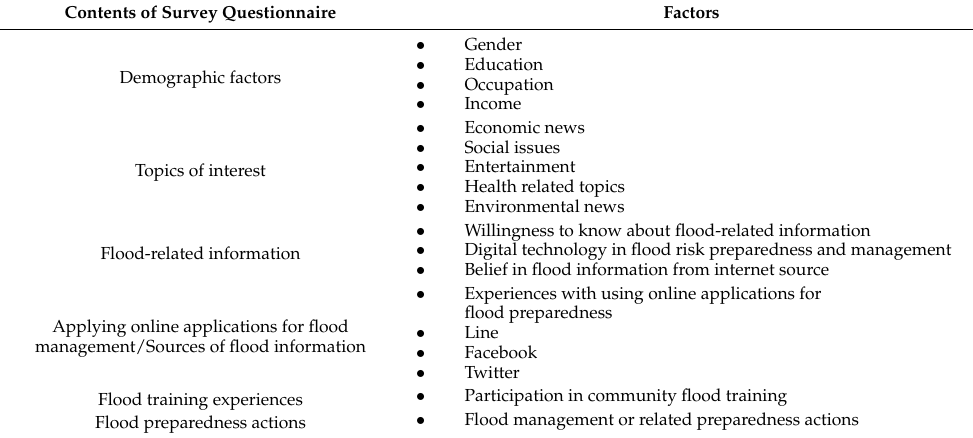
Table 1. Contents of survey